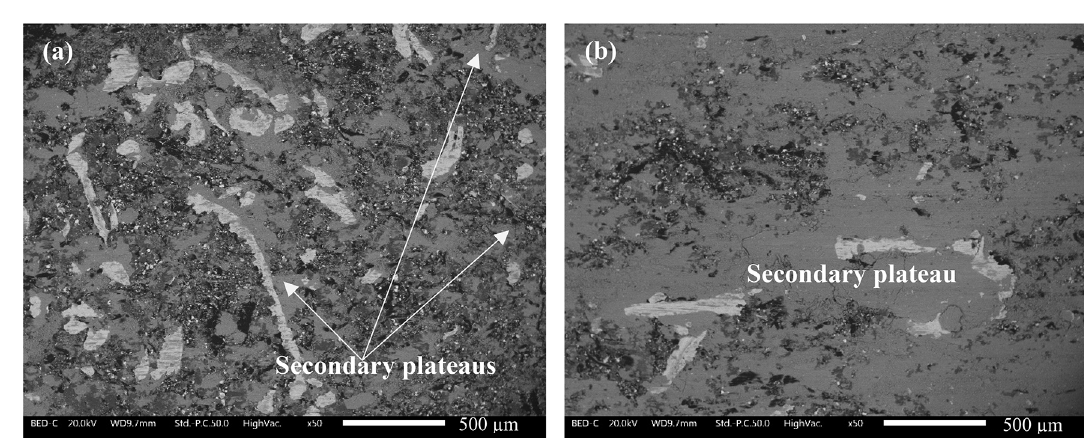
Figure 4. Typical examples of worn pin surface ( a ) Without damping tape; and ( b ) With damping tape in the BC